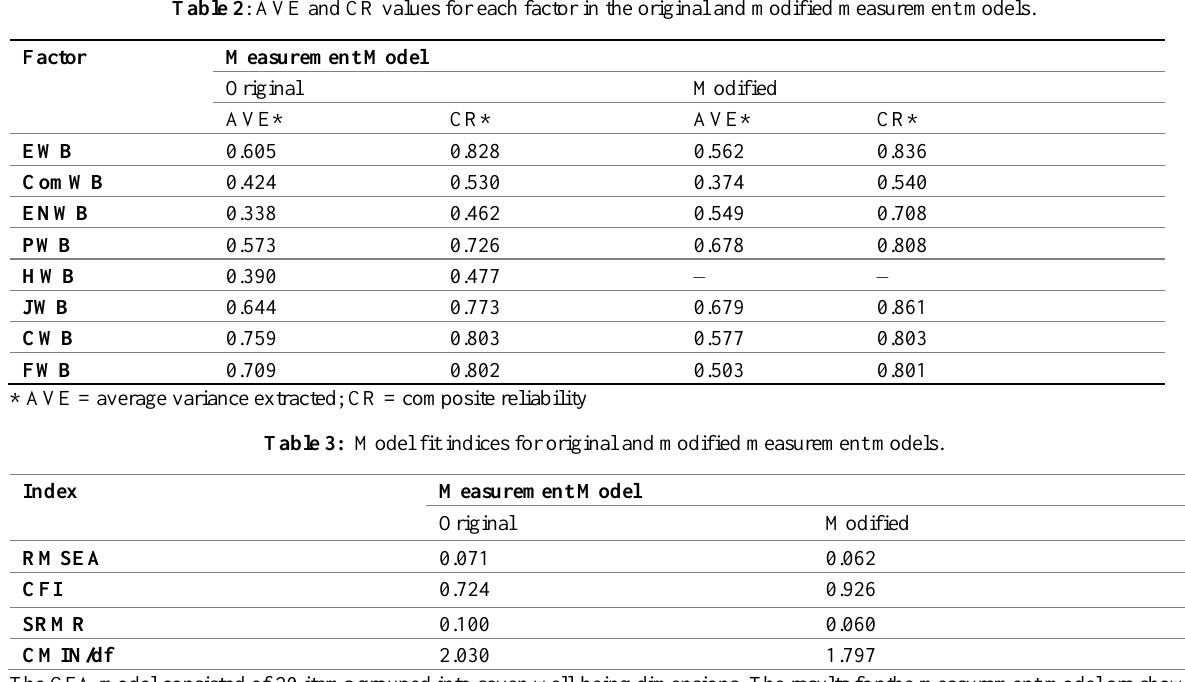
Table 2 : AVE and CR values for each factor in the original and modified measurement models.